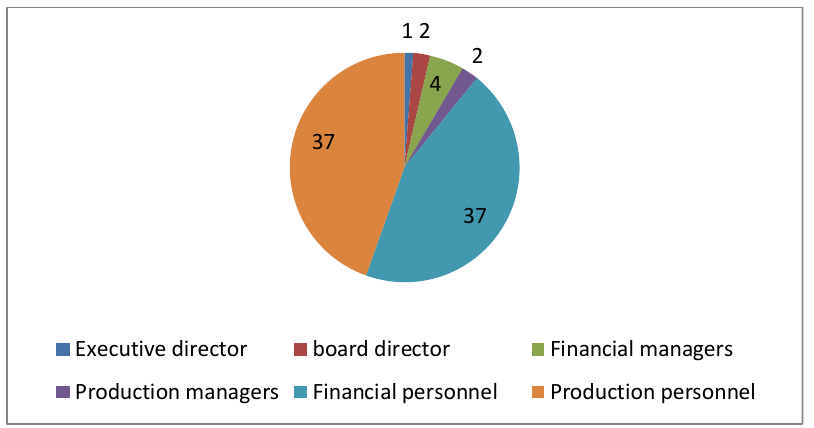
Fig. 2. Personal characteristics of the participants